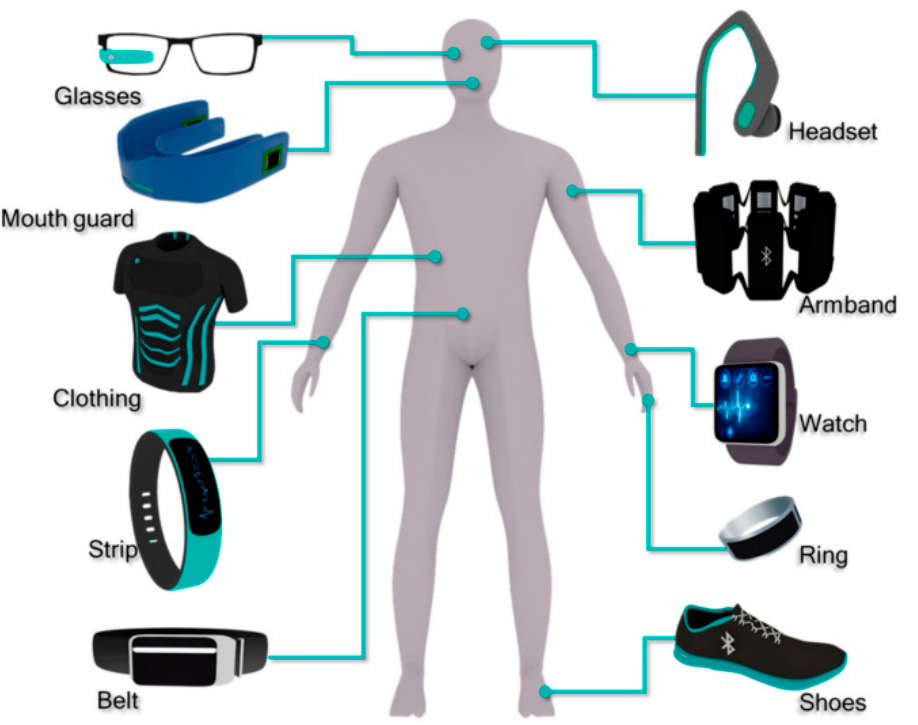
Figure 3. Portable and healthcare devices worn on body parts (reprint adapted with permission from Guk et al., 2019@MDPI; Ref [41]. Copyright 2019 MDPI).